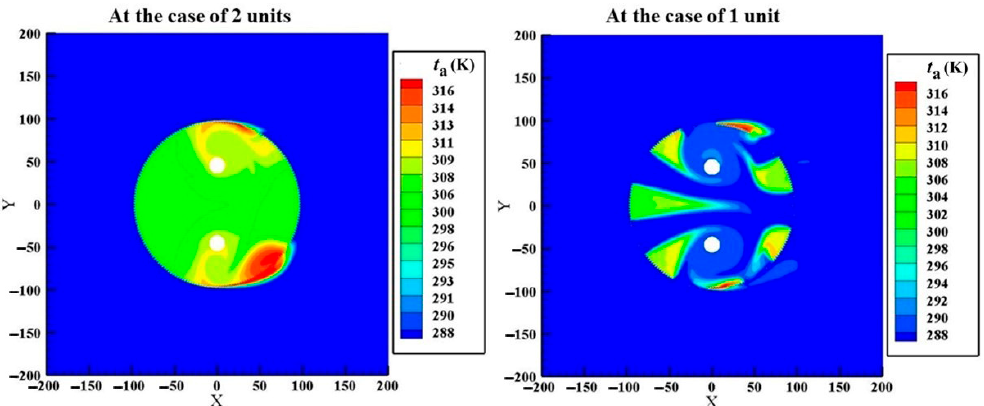
Figure 17. Comparison of temperature fields of ACHE under a typical crosswind of 12 m/s in the cases of 2 units and 1 unit.